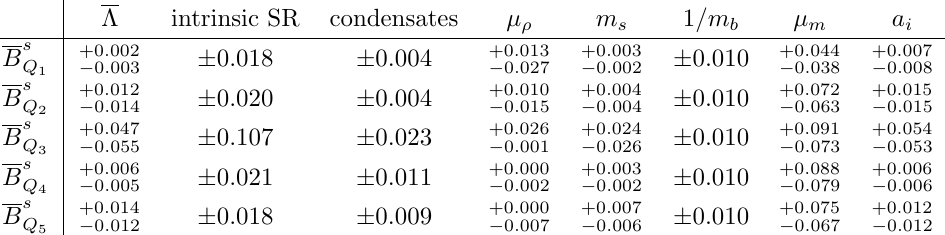
Table 2 . Individual errors for the Bag parameters in the B s system.